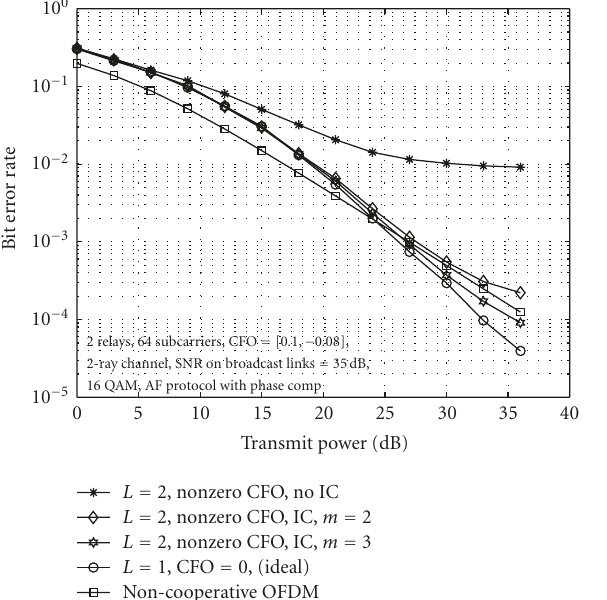
Figure 5: BER performance as a function of SNR for CO-SFBC- OFDM on frequency-selective fading ( L = 2). M = 64, 3 relays ( N = 3, G 3 code), CFO = [0.1, − 0.08, 0.06], 16-QAM, SNR on broadcast links = 35dB. AF protocol and phase compensation at the relays.